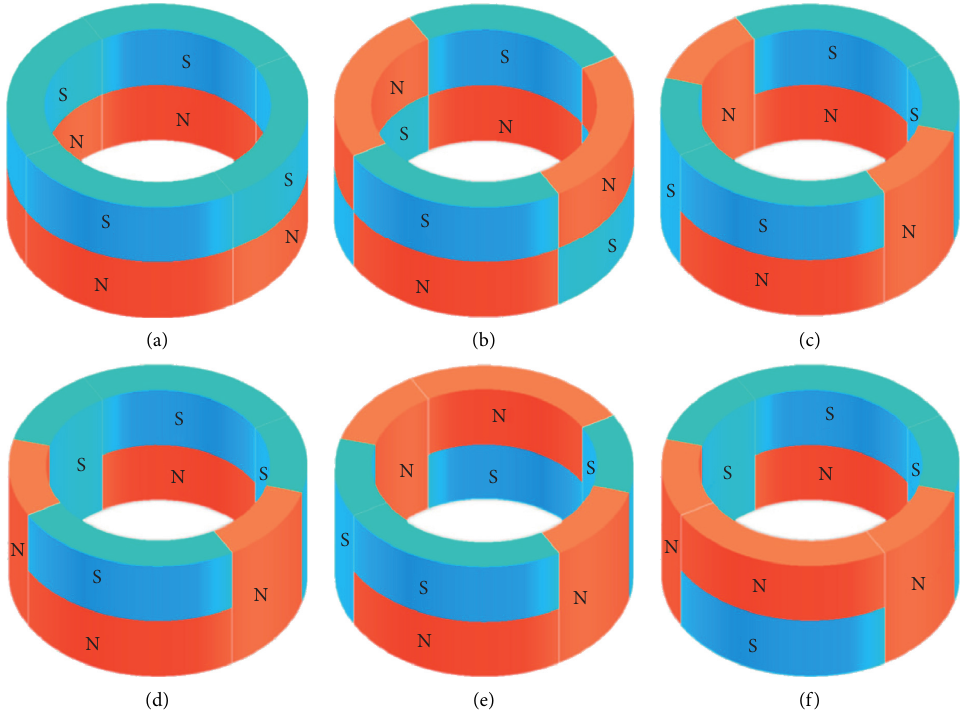
Figure 8: Magnetic circuit design scheme when the valve seat consists of four identical shape tile magnets. (a) Scheme 4. (b) Scheme 5. (c) Scheme 6. (d) Scheme 7. (e) Scheme 8. (f) Scheme 9.